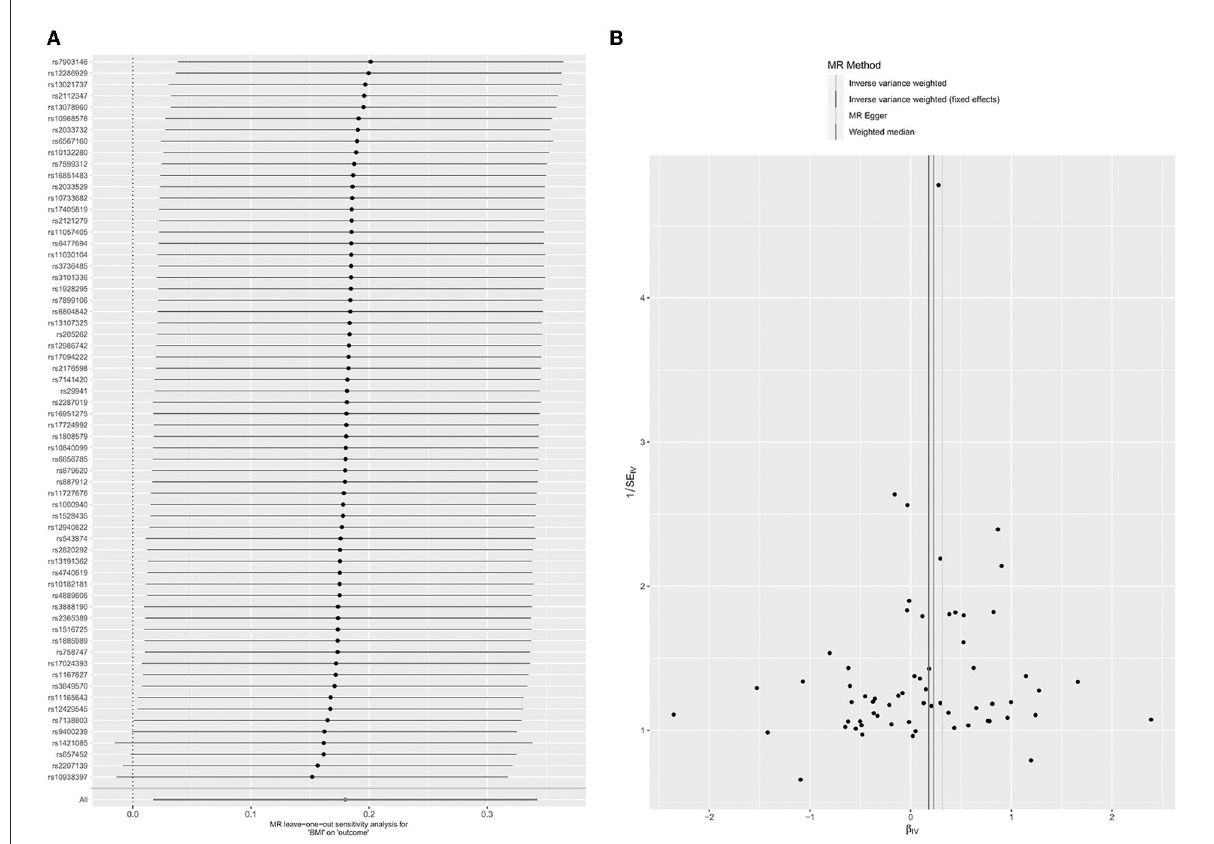
FIGURE2 Leave-one-out permutation analysis plot (A) and Funnel plot (B) of BMI.